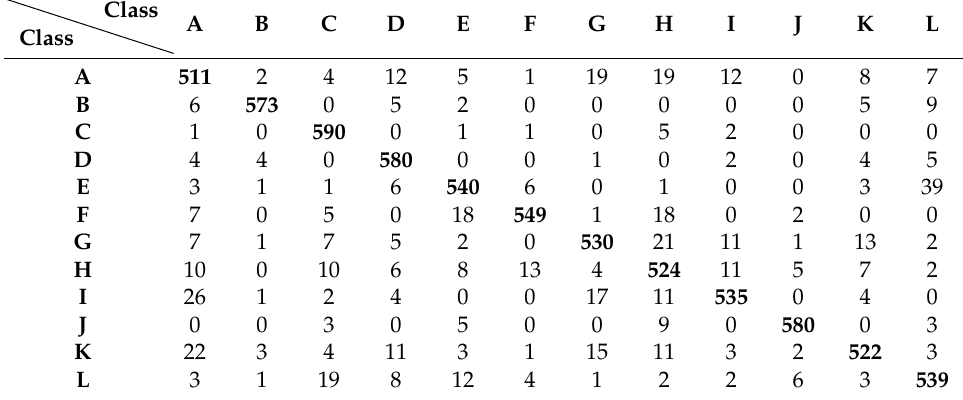
Table 12. Classification results after combination using DS theory for HOG and MLG features.